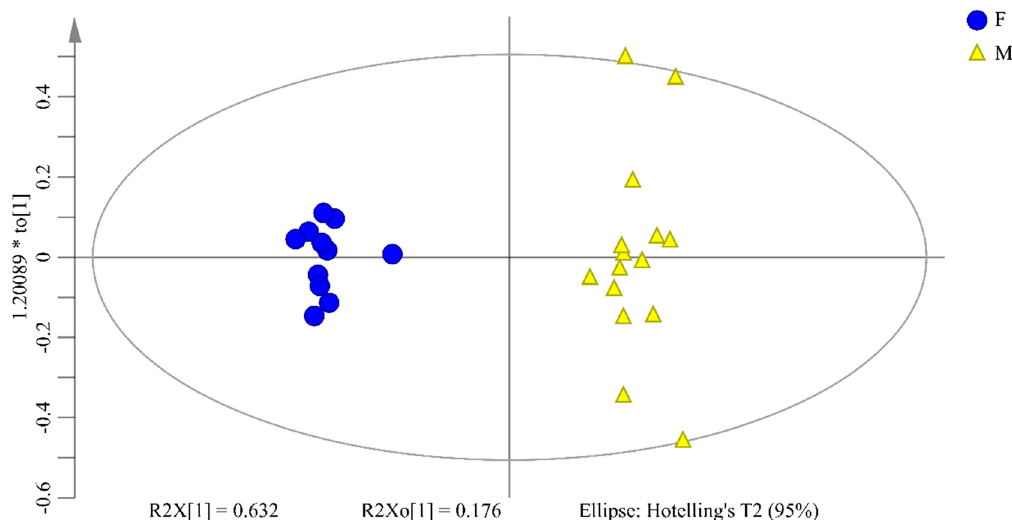
Figure 6. OPLS-DA scores plot for female and male flower buds of P. tomentosa . Circles represent female samples and triangles represent male samples. The X axis refers to the score of the first principal component (PC1) and the Y axis refers to the score of the second principal component (PC2). The variances accounted by PC1 and PC2 are 63.2% and 17.6%, respectively.